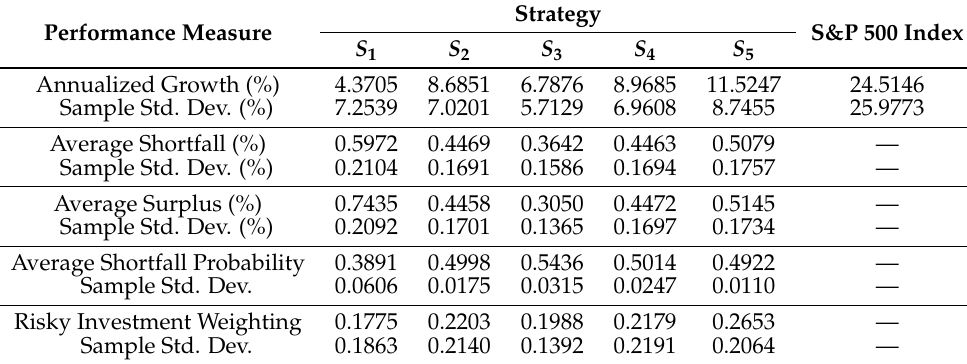
Table 7. Alternative portfolio performances for the out-of-sample